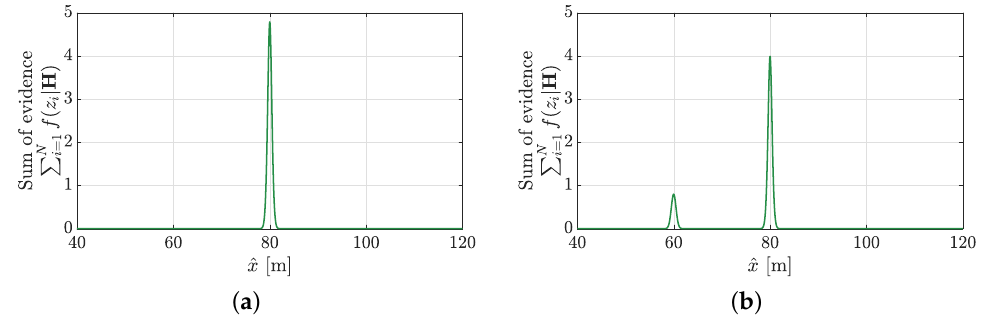
Figure 3. The evidence-based metric suggests that the hypothesis ˆ x = 80m is most likely even when the spurious measurement is introduced. ( a ) Evidence measured across the hypothesis space using the perfect measurement set in Figure 1a. ( b ) Evidence measured across the hypothesis space using the corrupted measurement set in Figure